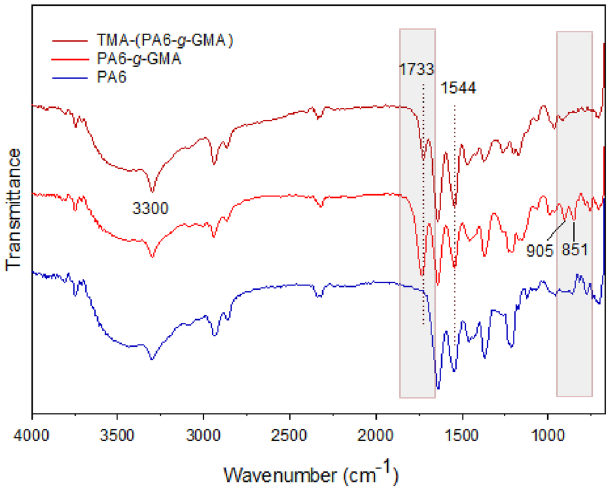
Figure 3. FTIR spectra of pristine PA6 fibers, PA6- g -GMA (200% DG), and TMA-(PA6- g